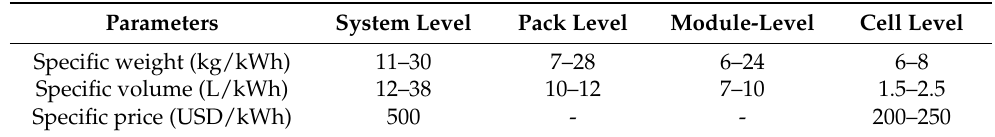
Table 6. Heavy-duty marine lithium-ion